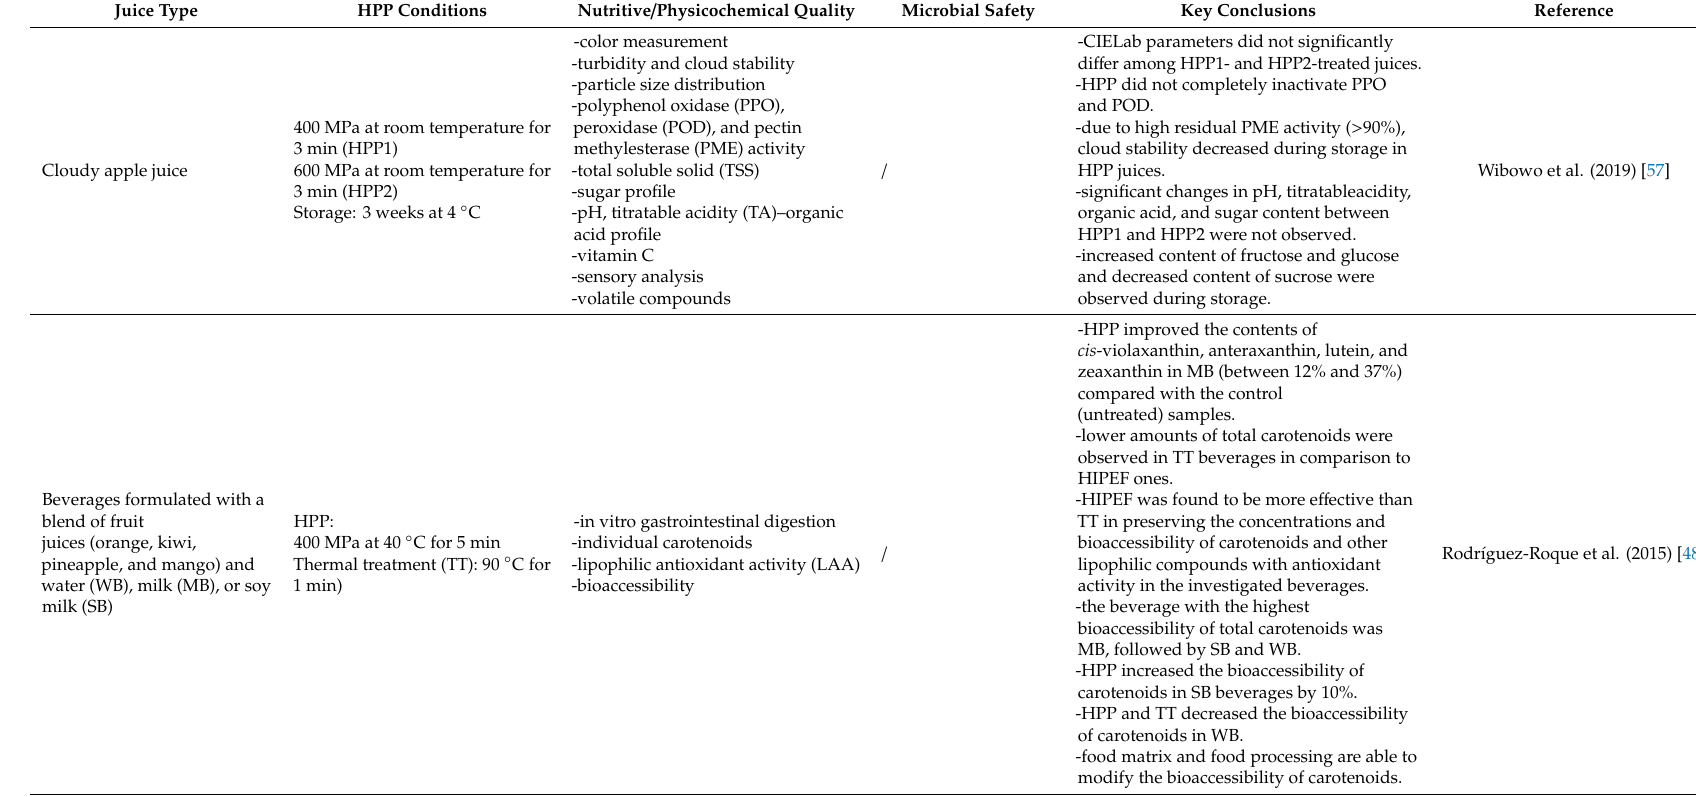
Table 3. Application of high-pressure processing (HPP) for the preservation of functional fruit juices and beverages over the last 5